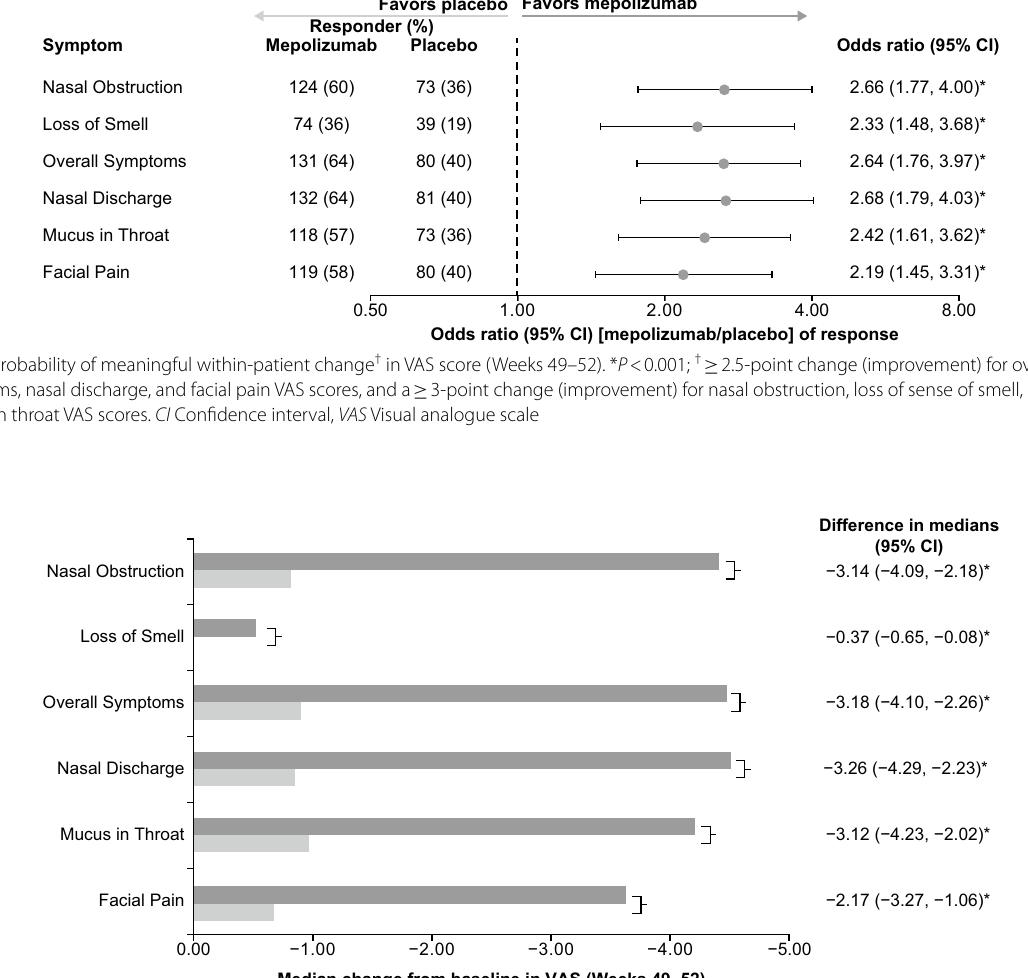
file 1: Table S5). Patients receiving mepolizumab had